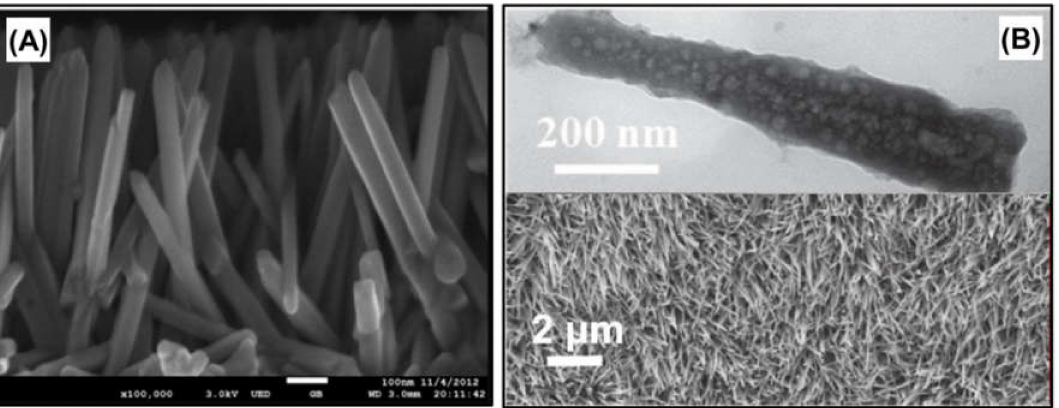
Figure 7. Transition metal-based nanomaterials employed as photocathodes in microbial electrolysis cells: ( A ) TiO 2 nanorods. Reprinted with permission from Ref. [43]. Copyright Elsevier 2013. and ( B ) CoP nanoarrays. Reprinted with permission from Ref. [46]. Copyright Elsevier